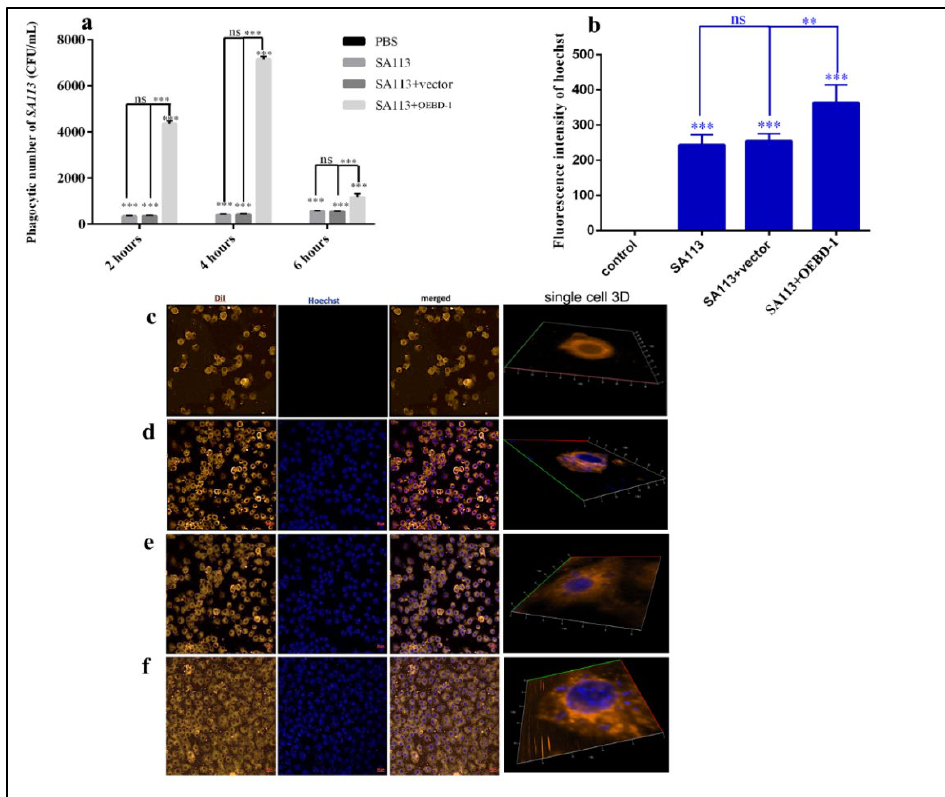
Figure 4. The numbers of J774A.1 phagocytoses SA113 counted by TSA culture ( a ). The fluorescent values of SA113 were displayed in the ZEISS system ( b ), and the data were achieved in three random visions ( n = 3). The single-cell 3D imaging was showed J774A.1 phagocytose SA113 in confocal microscopy, J774A.1 cells were marked by orange fluorescent, and SA113 was marked by blue fluorescence ( c – f ); ( c ) control or uninfected group, ( d ) SA113-infected group, ( e ) SA113+vector group, ( f ) SA113+ eBD-1 recombination protein. ** p < 0.01, *** p < 0.001, ns: no significant ( p > 0.05).